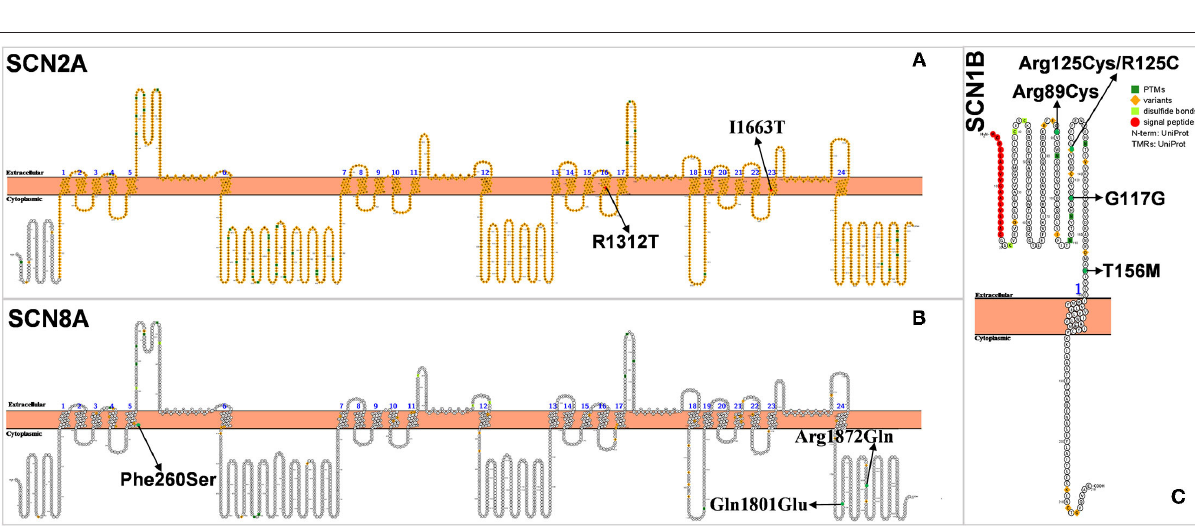
FIGURE 4 | (A–C) Schematic diagram of protein encoded by SCN2A, SCN8A , and SCN1B , illustrating the location of the amino acids affected by the mutations identified in patients. seizures (EIMFS), West syndrome, Doose Syndrome, LGS, and unclassified epileptic encephalopathy (38, 66,